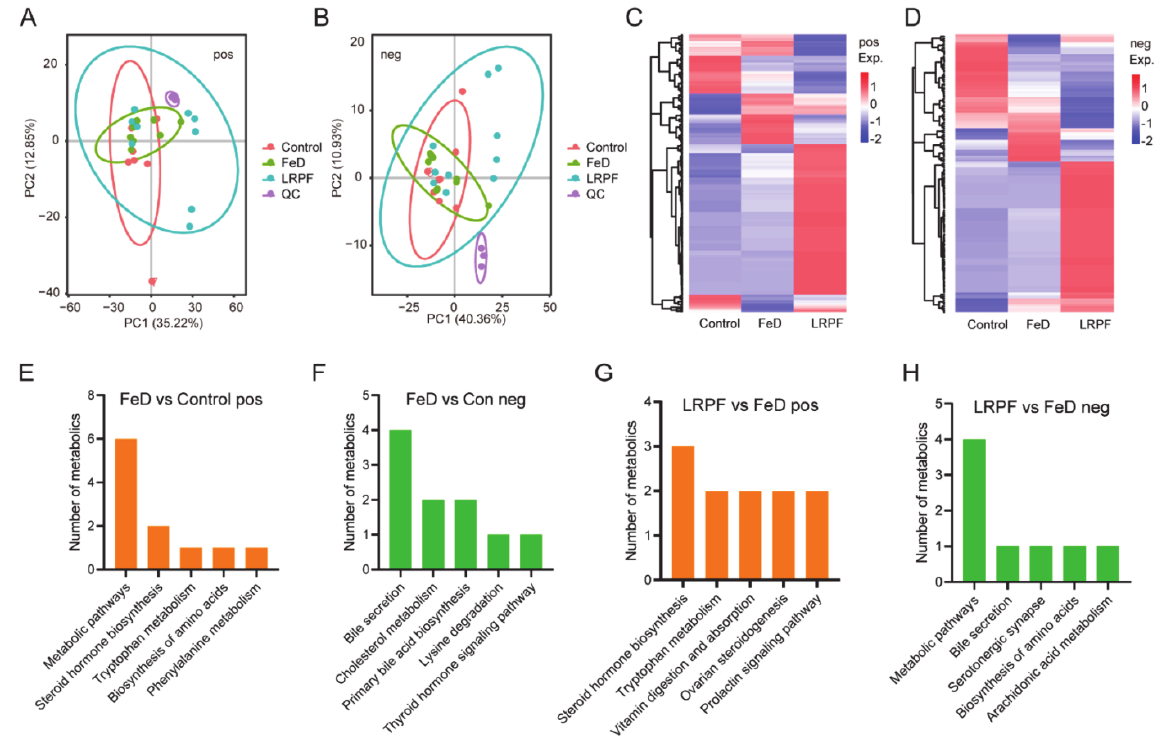
Figure 6. Effects of LRPF on the metabolome of mice with iron deficiency anemia. ( A ) The dot plot showing the top 2 PCs of positive ion (pos) metabolite. ( B ) The dot plot showing the top 2 PCs of negative ion (neg) metabolite. ( C ) The heat map showing the expression trends of the pos metabolites. ( D ) The heat map showing the expression trends of the neg metabolites. ( E ) The top 5 KEGG signaling pathways of differentially expressed pos metabolites between FeD vs. the control group. ( F ) The top 5 KEGG signaling pathways of differentially expressed neg metabolites between FeD vs. the control group. ( G ) The top 5 KEGG signaling pathways of differentially expressed pos metabolites between LRPF vs. the FeD group. ( H ) The top 5 KEGG signaling pathways of differentially expressed neg metabolites between LRPF vs. the FeD group.